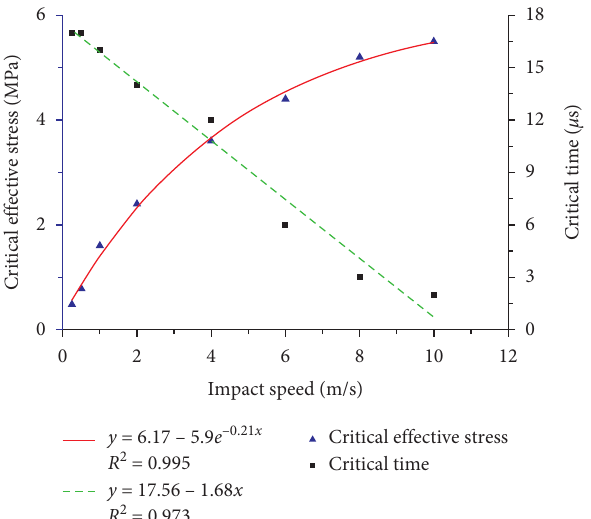
Figure 4: Fitting curves of critical effective stress, critical time, and speed.